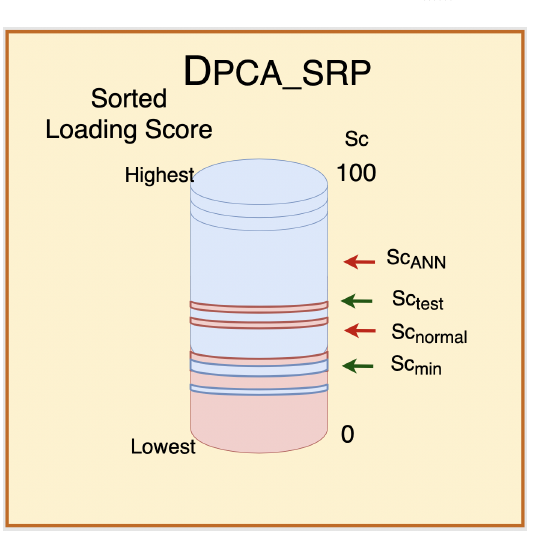
Figure 10. Sc—accuracy testing representation.